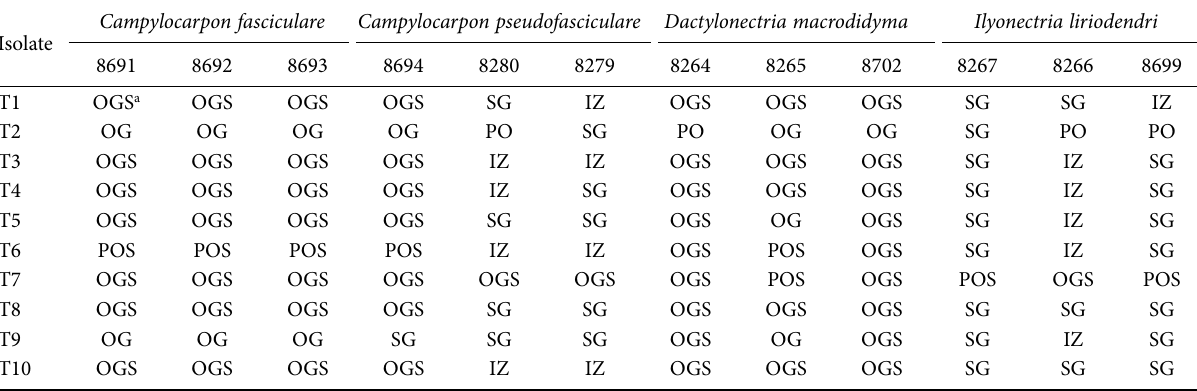
Table 4. Macroscopic interactions observed between Trichoderma isolates (T1 to T10), and the respective black foot disease pathogens (three isolates of each) in dual culture assays.